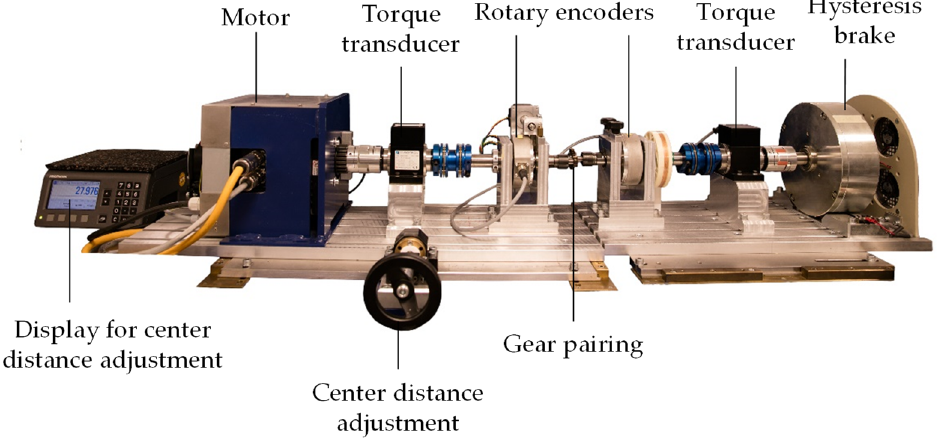
Figure 1. Main components of the in situ gear test rig of the LKT. The motor drives the steel pinion and the hysteresis brake generates the loading torque on the plastic gear. Torque fl uctuations during the test run and the according frequency spectrum on the input and output side are measured by torque transducers, type TMB307 by Magtrol, Rossens, Swi tz erland. The tooth temperature of the plastic gear is measured continuously by positioning a thermocouple, type K, in a drilled hole with a diameter of 0.6 mm in the tooth root area, in the middle of the tooth. The temperature information is conveyed to a data logging PC via telemetry, type TEL1-PLM-IND by Kraus Messtechnik GmbH, O tt er fi ng, Germany. The main measuring components for the tooth wear and deformation measurement are rotary encoders, type A020 by Fri tz Kübler GmbH, Villingen-Schwenningen, Germany on the input and output shaft. Figure 2 shows the main components of the in situ gear test rig of the LKT. In order to measure the tooth fl ank wear and elastic tooth de fl ection of the plastic gear on the output side, the index pulses of the rotary encoders on the input and output shaft are evaluated. With progressing wear and deformation, the index pulse of the gear delays. Thus, the timing di ff erence between the input and output index pulses increases (t 0 < t 1 ) as shown in Figure 2.